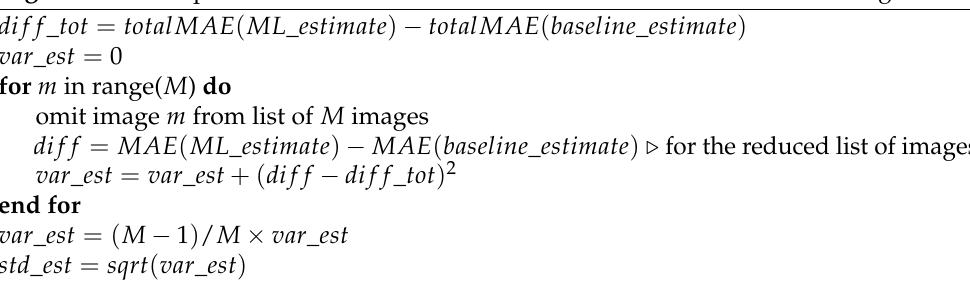
Algorithm 1 Computation of MAE for the difference between baseline and ML